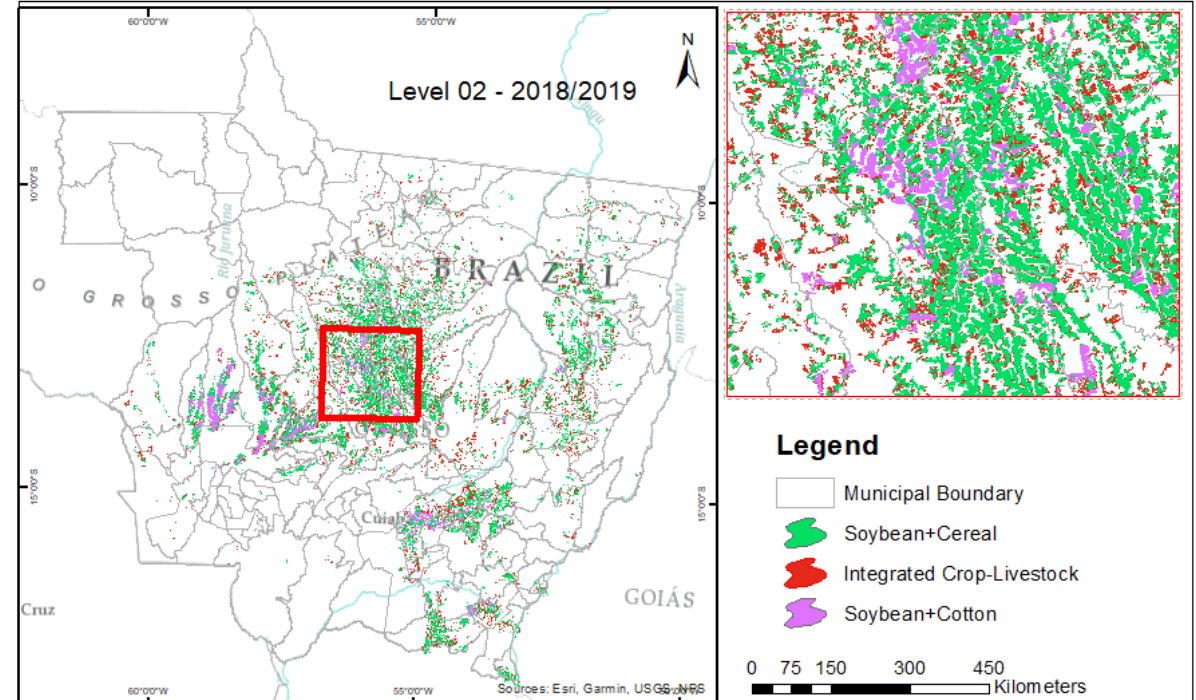
Remote Sens. 2021 , 13 , x FOR PEER REVIEW 16 of 22